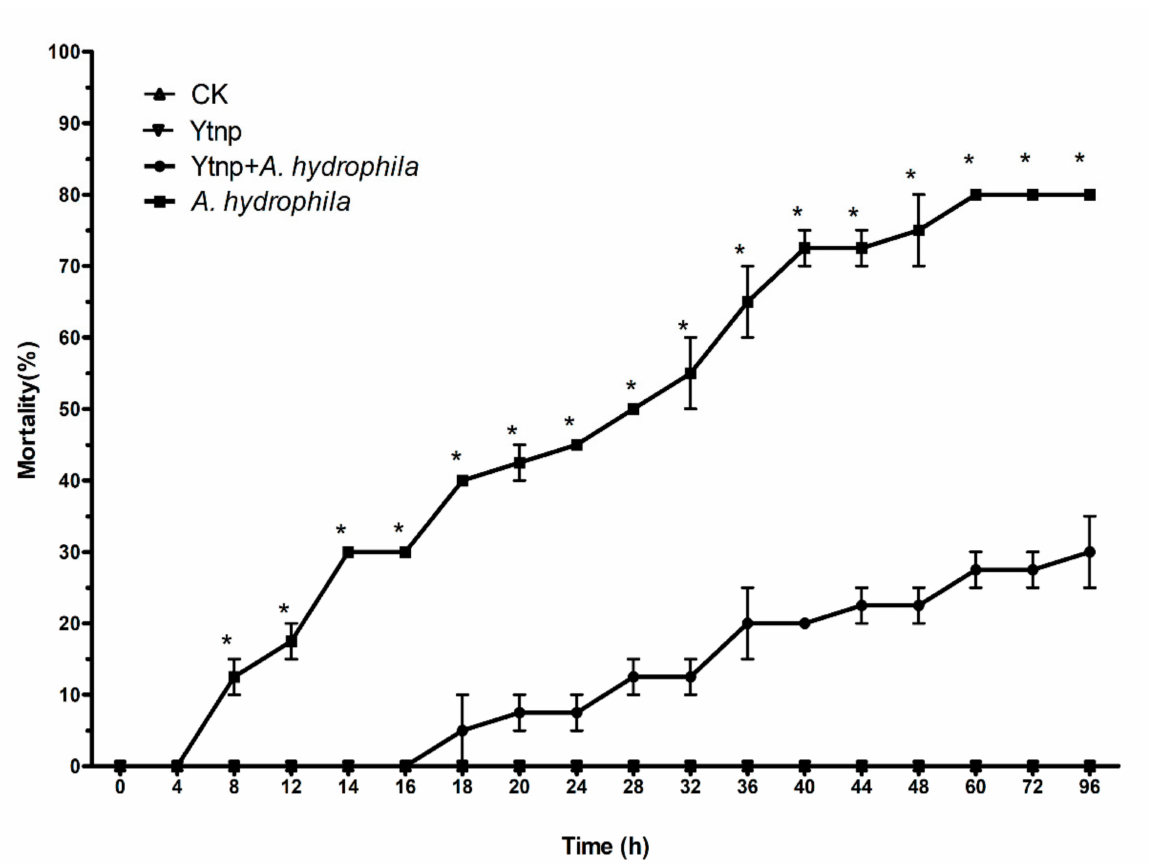
Figure 7. Mortality of C. auratus injected intraperitoneally with A. hydrophila ATCC 7966 or A. hydrophila ATCC 7966 and YtnP. Groups were as follows: Group A (CK) was injected with sterile PBS buffer, Group B (YtnP) was injected with AHLase YtnP, Group C (YtnP + A. hydrophila ) was injected with A. hydrophila ATCC 7966 + AHLase YtnP, Group D ( A. hydrophila ) was injected with A. hydrophila ATCC7966. Each value is mean ± SD ( n = 2), data marked with “*” means significant difference (one-way ANOVA; p < 0.001) among